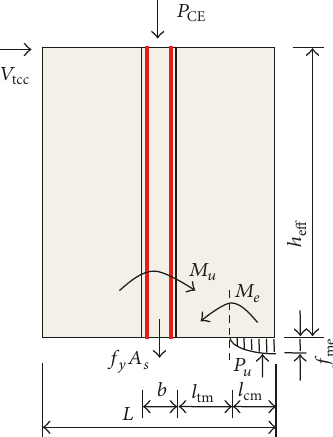
Figure 5: Mechanical model of rocking masonry walls with an SCC.